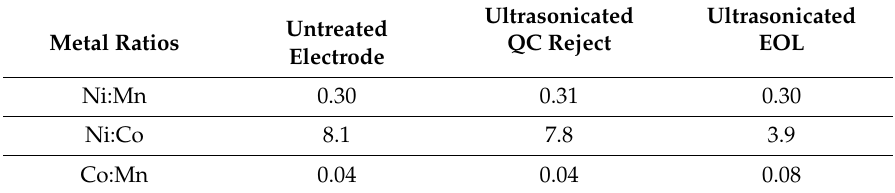
Table 2. Metal Ratios of an untreated electrode (Data from Table S2.1) and two electrodes treated with the ultrasonic separation technique.